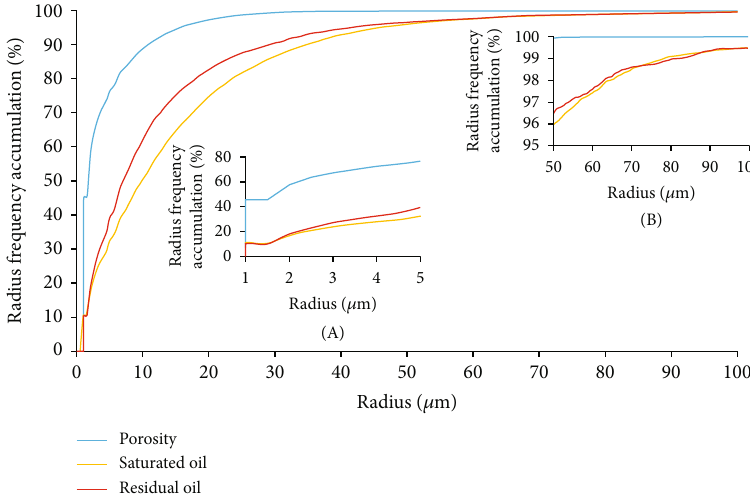
Figure 5: Probability accumulation curve of pore distribution under di ff erent states (dry sample, saturated oil, and residual oil): (A) cumulative distribution of pore radius from 1 μ m to 5 μ m; (B) cumulative distribution of pore radius from 50 μ m to 100 μ m.